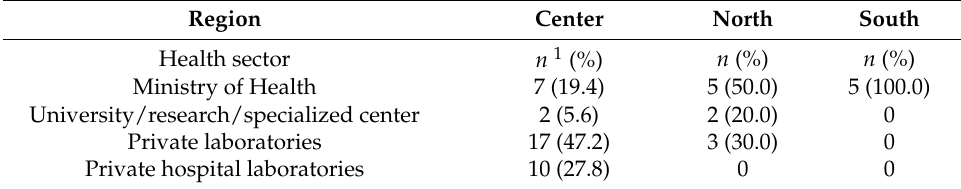
Table 1. General features of the participating laboratories. Region